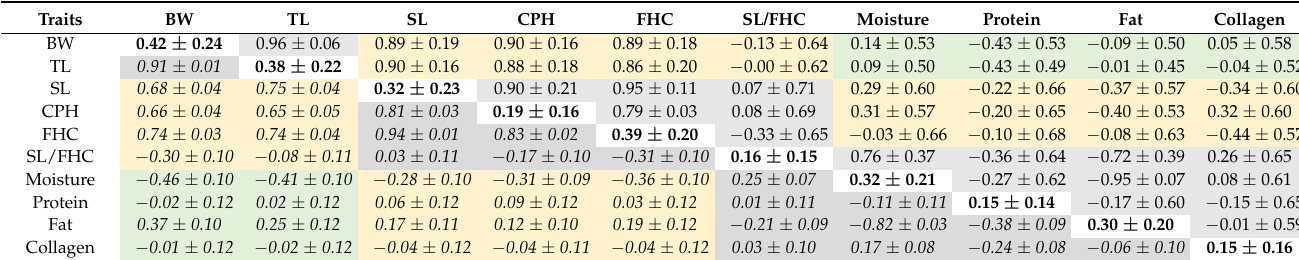
Table 5. Heritabilities (in bold at diagonal, with standard error), phenotypic correlations (below the diagonal in italics, with standard error), and genetic correlations (above the diagonal, with standard error) for manual growth, automatic morphology, and flesh composition measurements, in meagre at harvest size (549 dph). Traits